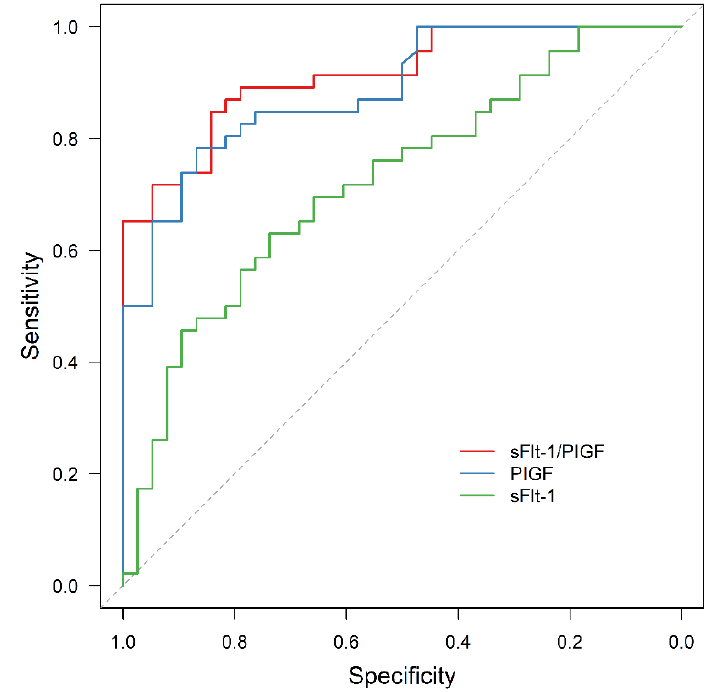
Figure 5. ROC curve for APO prediction in the subgroup of normal-weight women by sFlt-1 (AUC = 0.723, 95% CI: 0.615–0.832, p < 0.001), PIGF (AUC = 0.892, 95% CI: 0.826–0.958, p < 0.001) and sFlt-1/PIGF (AUC = 0.914, 95% CI: 0.857–0.972, p < 0.001). ROC receiver operating characteristic, APO adverse perinatal outcome, sFlt-1 soluble fms-like tyrosine kinase-1, PIGF placental growth factor.